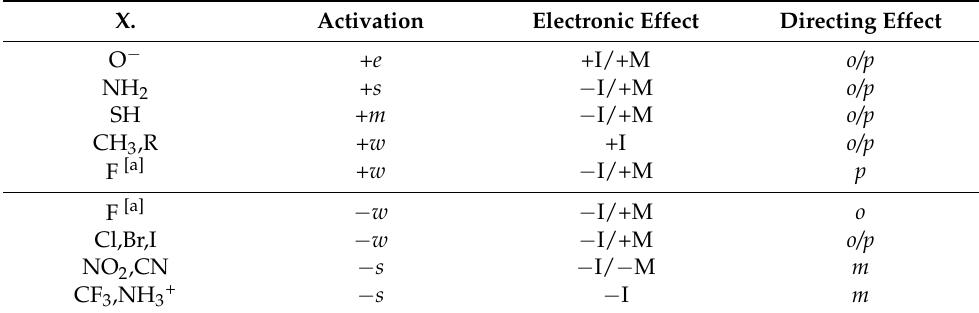
Table 1. Classification of X substituents according to their behavior against aromatic electrophilic substitution. Activating/deactivating groups are marked by +/ − signs, respectively, and the e , s , m , and w labels refer to extreme, strong, medium or weak effects. Similarly, I and M refer to inductive and mesomeric effects, and +/ − signals whether the group donates or extracts electronic charge from the